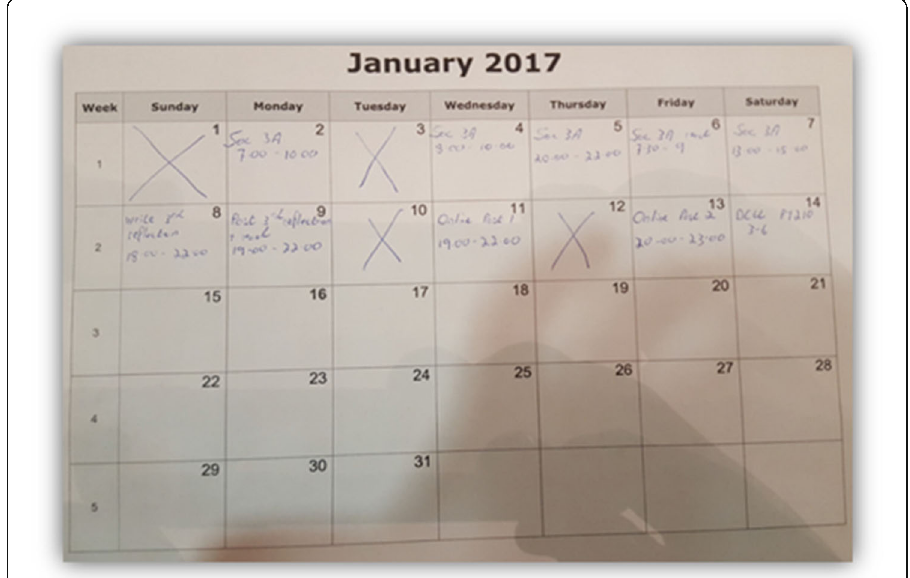
Fig. 3 Study plan: P17 eportfolio entry